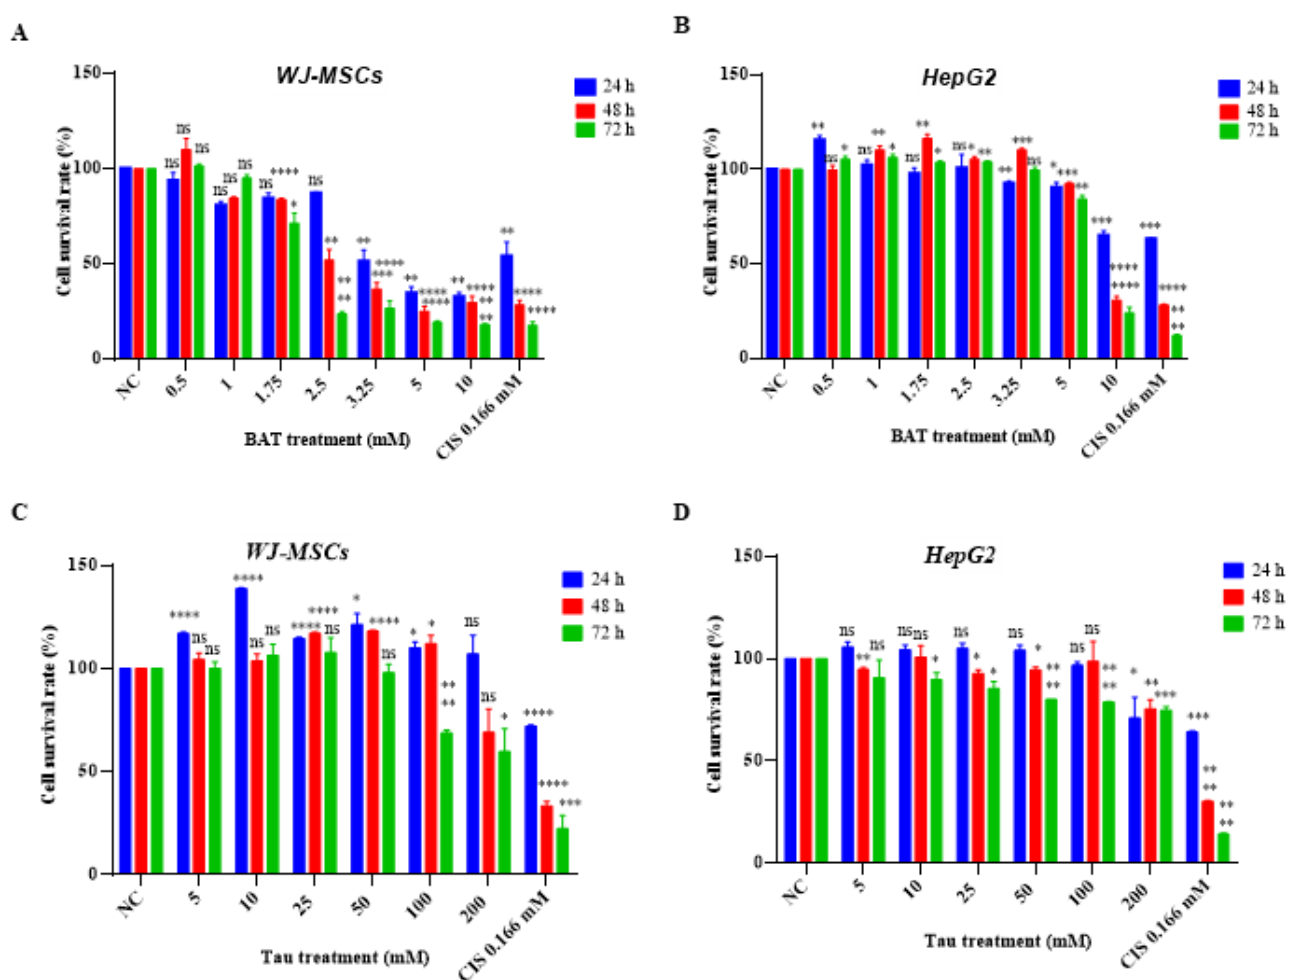
Figure 3. Both BAT and Tau exerted their cytotoxicity in a concentration-dependent manner. The following cells: ( A,C ) Wharton’s Jelly mesenchymal stem cells (WJ-MSCs) and ( B,D ) HepG2 cells were treated with (0.5–10 mΜ) BAT or (5–200 mΜ) Tau or 0.166 mM CIS for 24–72 h. The percentage of viable cells upon BAT or Tau treatment versus negative control (NC) was assessed, using the Crystal Violet procedure and statistical analysis was performed. Ns: not significant, * p < 0.05. ** p < 0.01. *** p < 0.001. **** p < 0.0001.